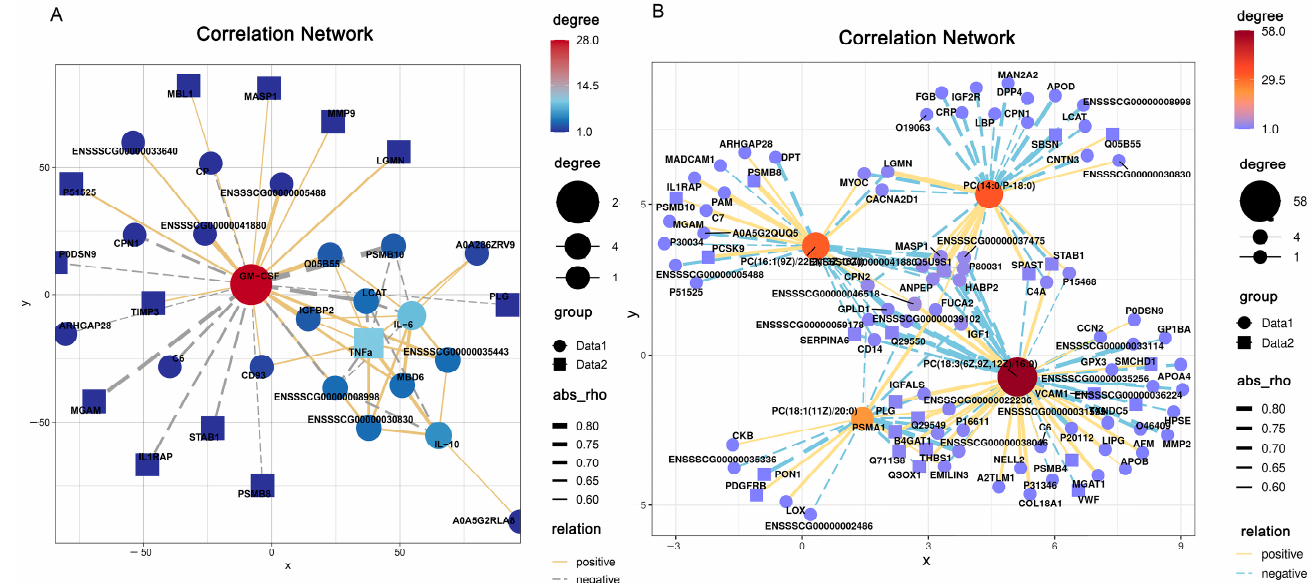
Figure 8. Correlation interaction network analysis based on significantly different proteins and metabolites. ( A ) Protein-cytokine interaction network analysis; ( B ) Protein-metabolite interaction network analysis. The yellow dashed line indicates a positive correlation, and the grey ( A ) and blue ( B ) dashed lines indicate a negative correlation. The thickness or thinness of the dashed lines indicates strong and weak correlations, respectively. p -values ≤ 0.05 were considered significant; p -values ≤ 0.01 were considered extremely significant. R2 ≥ | ± 0.5| represents strong correlation.